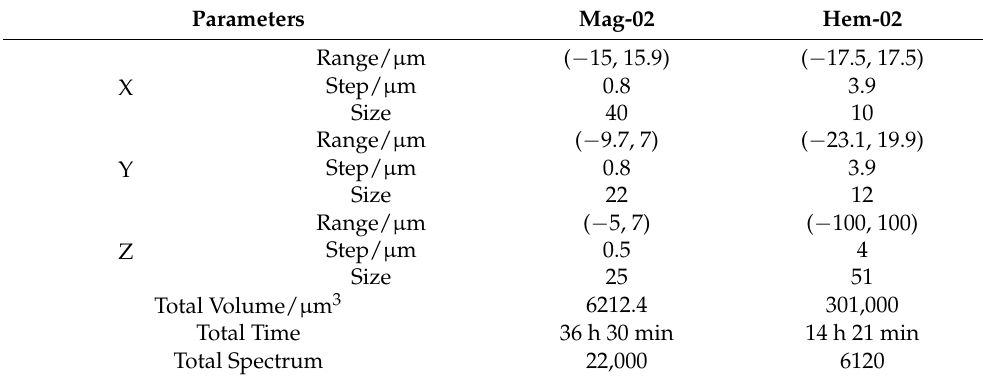
Table 1. The 3D Raman mapping parameters on the magnetite and hematite inclusions. Parameters Mag-02